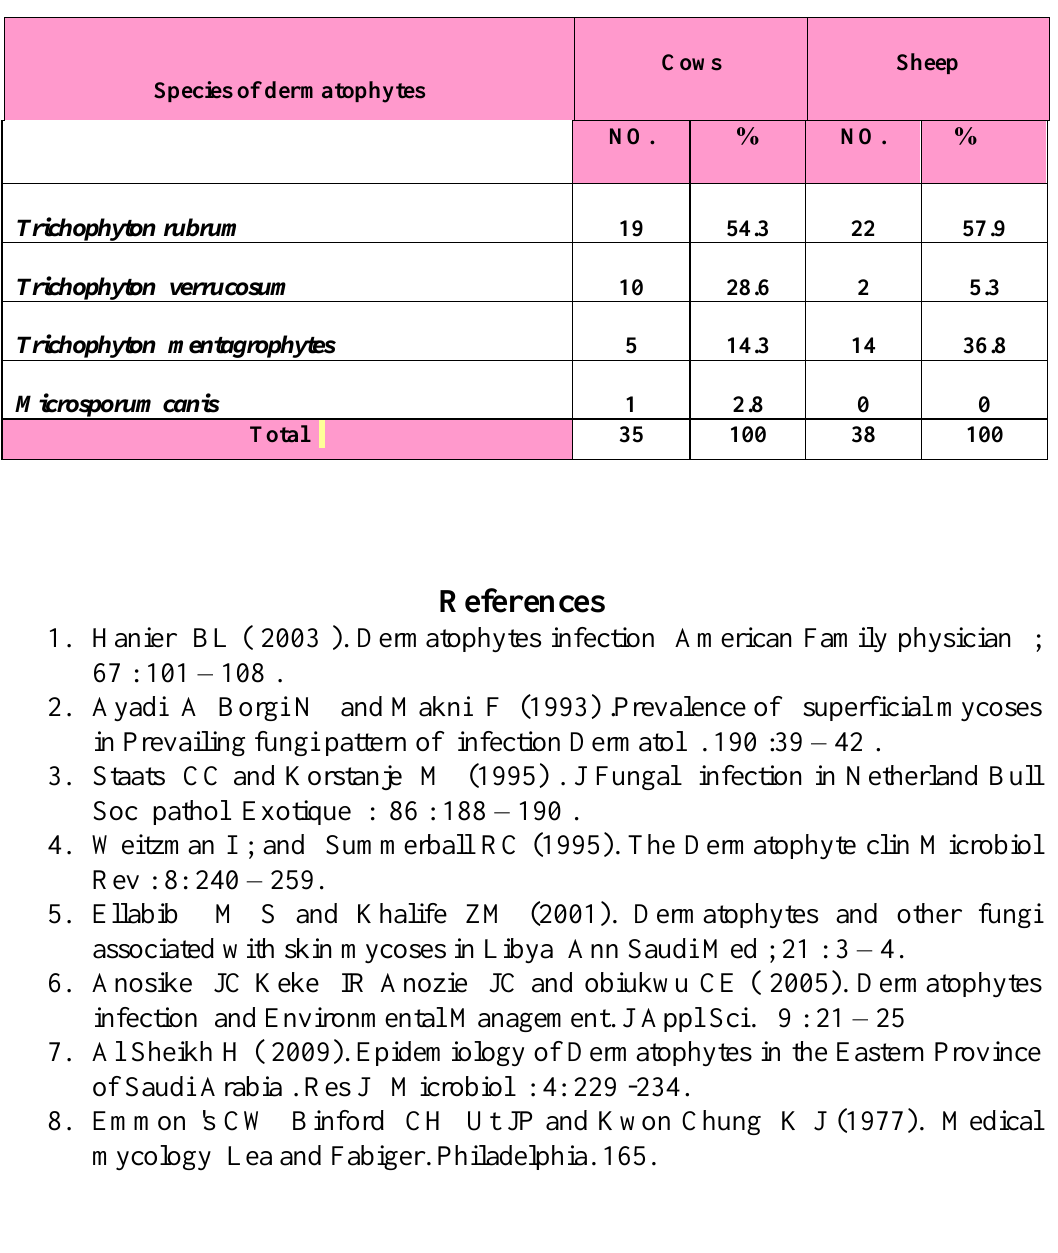
Table (3): The number and percentage of dermatophytes species isolated from 50 Cows and 50